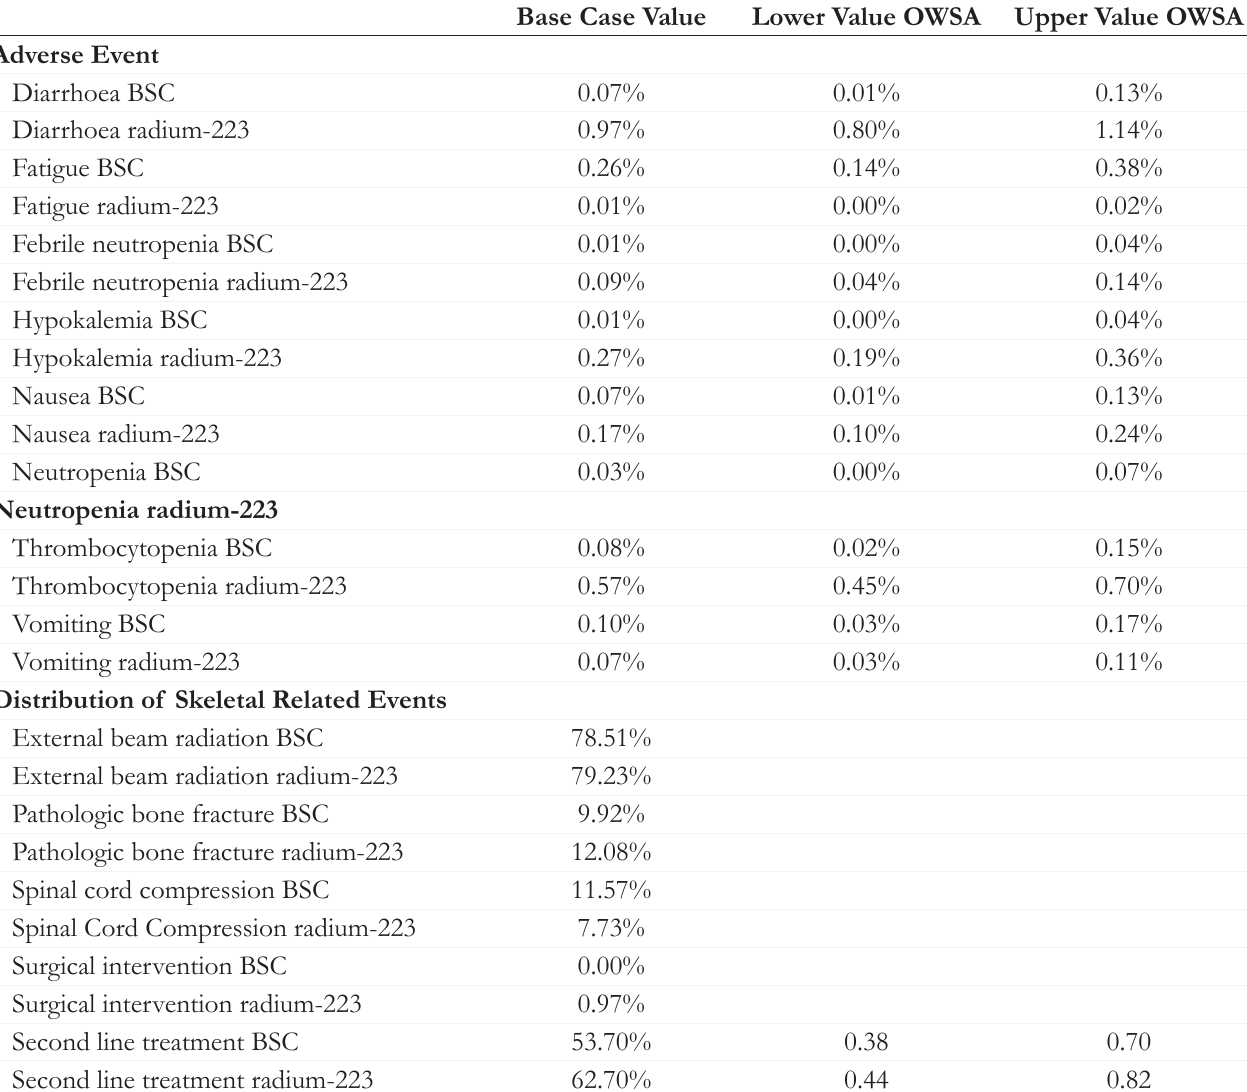
Table 1. Clinical Inputs Used to Populate the Model